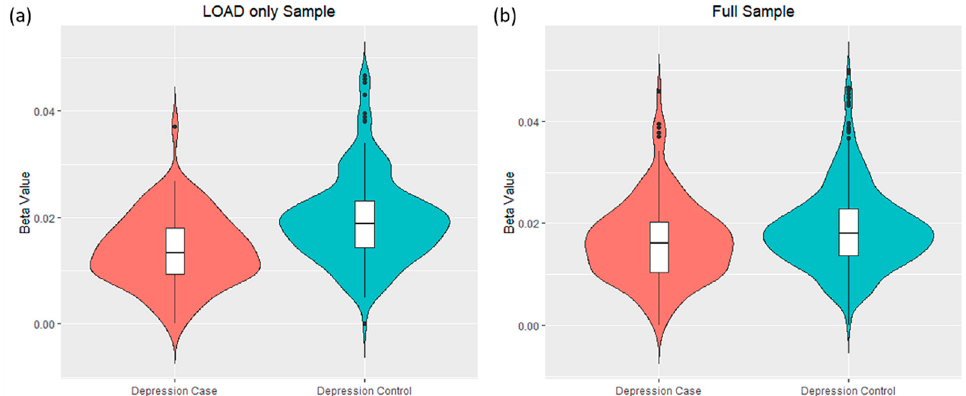
Figure 2. Differential DNA-methylation identified lower methylation levels at one CpG site within CpG Island positioned at Chr17:73,511,016-73,513,176 (measured by probe cg20442550) in LOAD with depression compared to LOAD only. Beta-values represent methylation on a 0–1 scale, with 1 indicating 100% methylation. Beta-values for this CpG site were plotted against depression case– controls in the ( a ) LOAD only and ( b ) full sample, i.e., LOAD and normal control. This CpG site showed significantly lower levels of DNA-methylation only with the LOAD sample (( a ) beta = − 116.6, log 2 FC = − 0.500, p = 0.004).